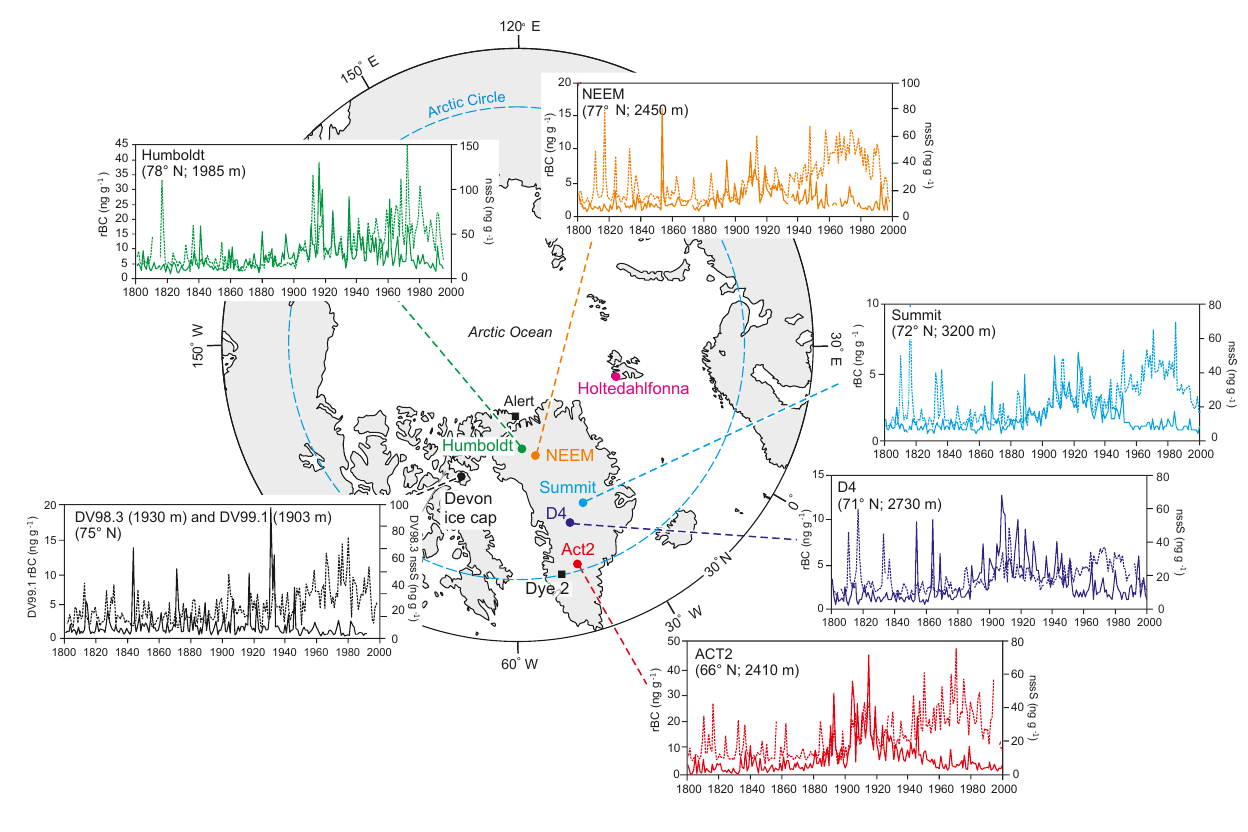
Figure 5. The record of atmospheric rBC and non-sea salt sulfur (nssS) deposition on Devon ice cap over the period from 1800 to 2000 compared with similar records developed at various sites in Greenland by identical or almost identical methods. Full lines are rBC; stippled lines are nssS. Data from Summit, D4, ACT2, and Humboldt are sourced from McConnell et al. (2007) and Koch et al. (2011), and data from NEEM are sourced from Zennaro et al. (2014) and Sigl et al. (2015). Also shown is the location of the ice-core record of elemental carbon deposition developed from Holtedahlfonna, Svalbard, by Ruppel et al. (2014), in addition to other sites (Alert, Dye 2) mentioned in the